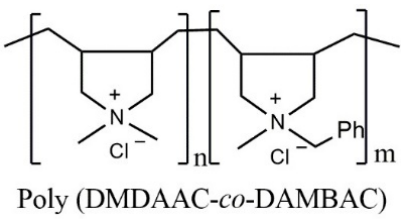
Figure 9. The structure of poly (DMDAAC ‐ co ‐ DAMBAC) ( n:m = 9:1).